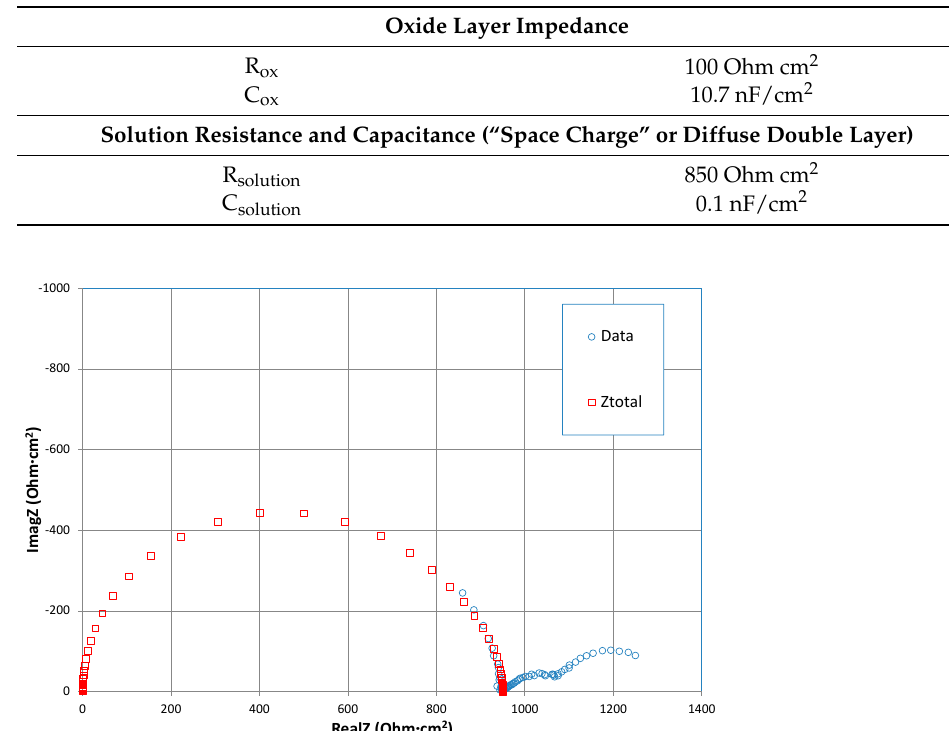
Table 4. Values for the high frequency impedance calculation.